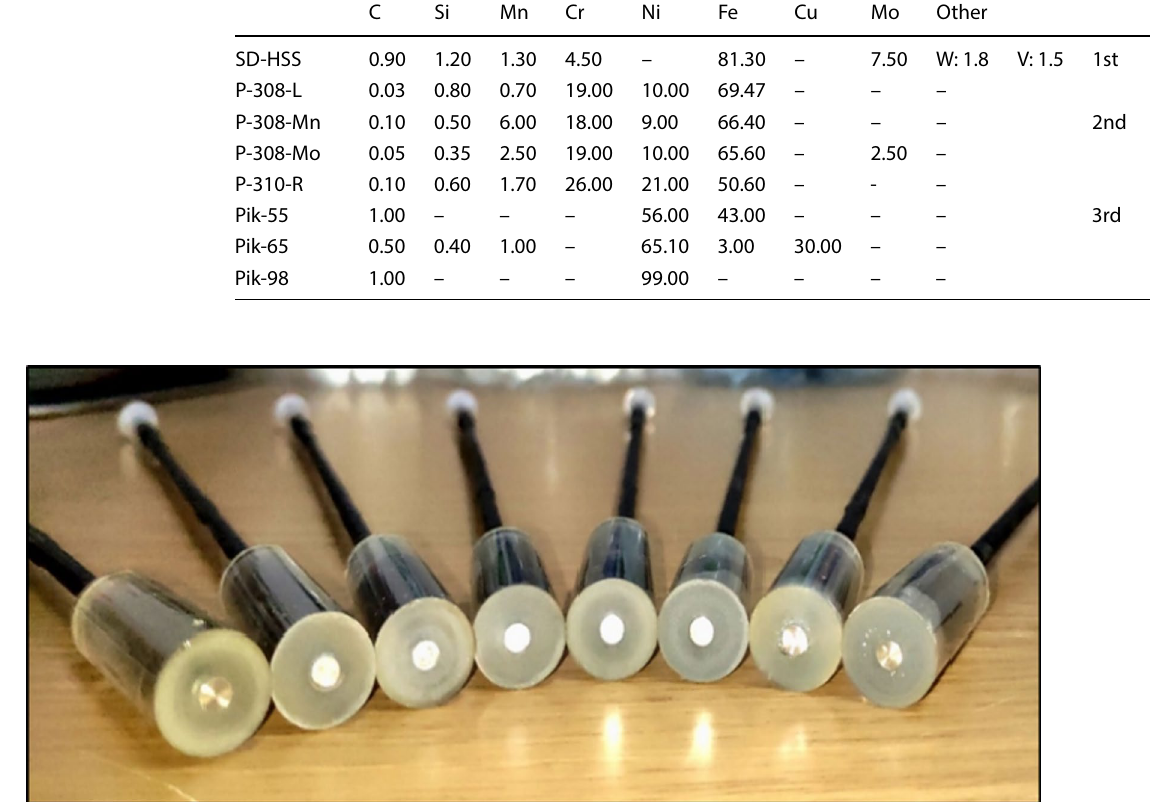
Table 1 Composition of the electrode materials